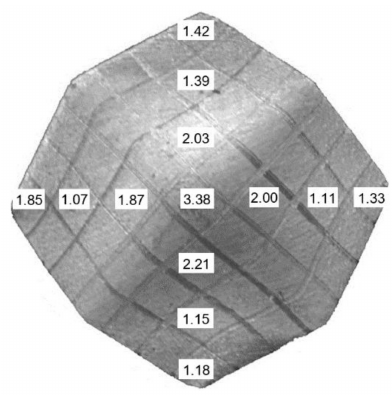
Figure 8. Distribution of the equivalent strain after the eighteenth stage of the process.